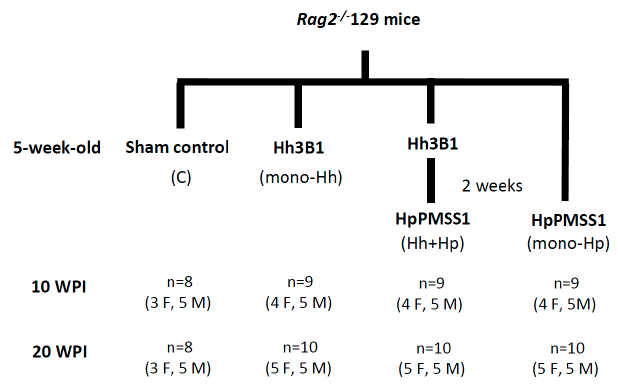
Figure 1. Schematic depiction of experimental design of infection. Five-week-old mice were inoculated with Hh 3B1; a subset of Hh -infected mice was then inoculated with Hp PMSS1 two weeks later. Abbreviations: Hh3B1 for H. hepaticus 3B1; HpPMSS1 for H. pylori PMSS1; M for male; F for female. Int. J. Mol. Sci. 2020 , 21 , x FOR PEER REVIEW All Hh-infected mice, regardless of Hp infection status or sex, developed significantly severe cecal and colonic pathology compared to the sham controls and mono-Hp groups (Figures 2 and 3A, p < 0.0001). The lesions in the cecum and colon were characterized by moderate to severe mucosal and submucosal inflammation comprising predominantly of dense coalescing aggregates of granulocytes (neutrophils, eosinophils) and macrophages intermingled with few mononuclear cells with lymphoid phenotypic appearance that were interpreted as innate lymphoid cells as mature lymphocytes are typically absent in RAG2 mice. The lesions were slightly more severe in the cecum compared to colon (Figures 2 and 3, Figures S2 and S3) and were also slightly more severe at 21 WPI (weeks post-Hh infection) than 10 WPI. In addition to inflammation, there were prominent epithelial defects characterized by surface erosions, epithelial degeneration/necrosis, ectactic glands, and crypt abscesstation as well as edema, mild crypt atrophy, marked epithelial hyperplasia, and moderate to severe dysplasia, which, in a few animals, progressed to villo-papillary adenomatous proliferations (intra-epithelial neoplasia) and/or invasive carcinoma (intramucosal or submucosally invasive carcinoma). In the colon, the lesions were observed in the distal colon, rectum, mid or transverse colon, and proximal colon with a decreasing order of severity. Cecal lesions were more severe at the ileo-cecal junction and in most instances also extended to the entire cecum in varying grades.